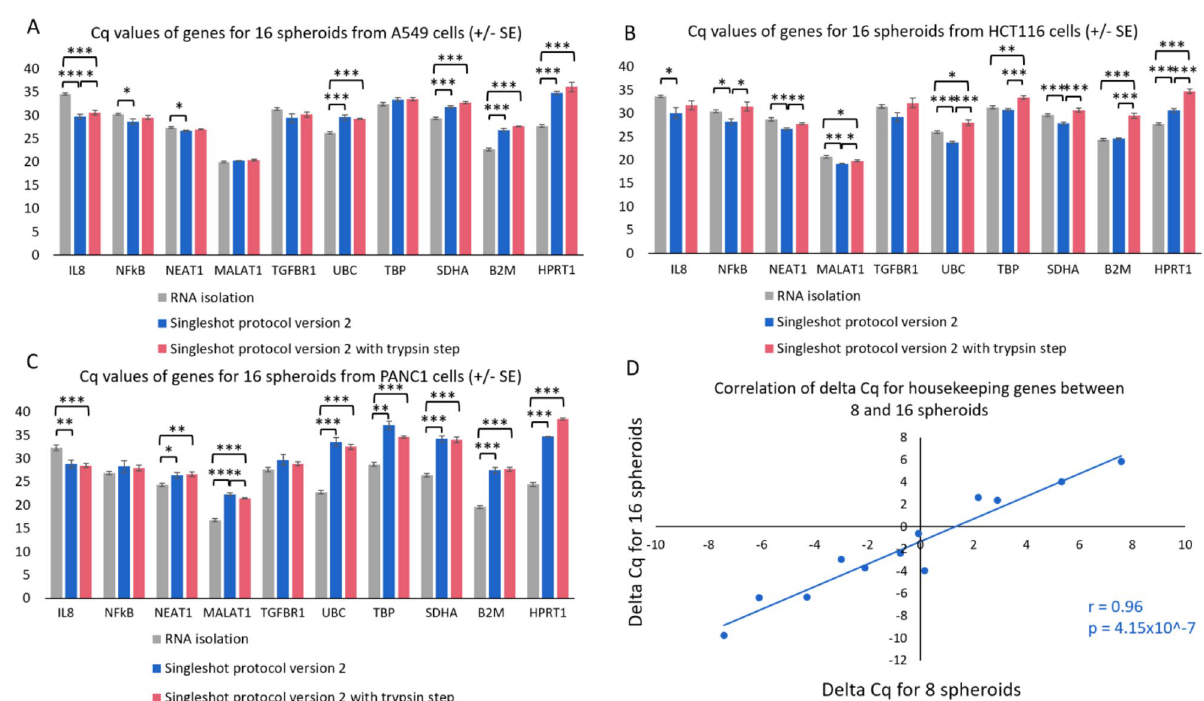
Figure 4. Cq values for 10 genes measured in three cell lines (A549 ( A ), HTC116 ( B ) and PANC1 ( C )) on RNA extractions (grey) and on lysates generated using the Singleshot protocol version 2 (blue) or lysates generated using the Singleshot protocol version 2 and an additional Trypsin step (red). Data are presented as mean ± SE with * P < 0.05; ** P < 0.01 and *** P < 0.001 (n = 3). Delta Cq values of house keeping genes between cell lines for 8 and 16 spheroids ( D